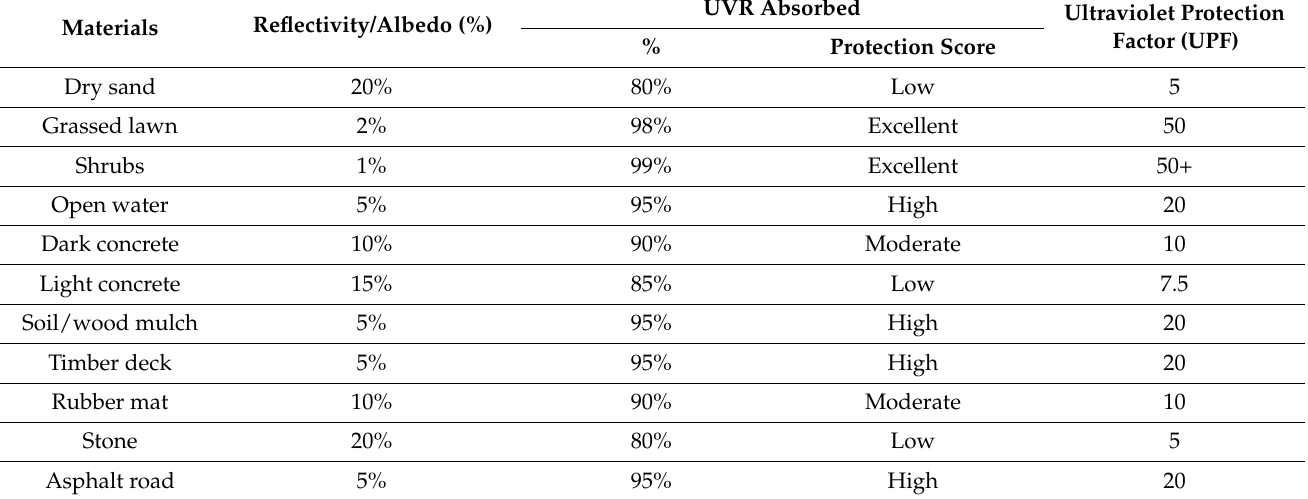
Table 3. Materials, their respective albedo values, and UPF offered [31].